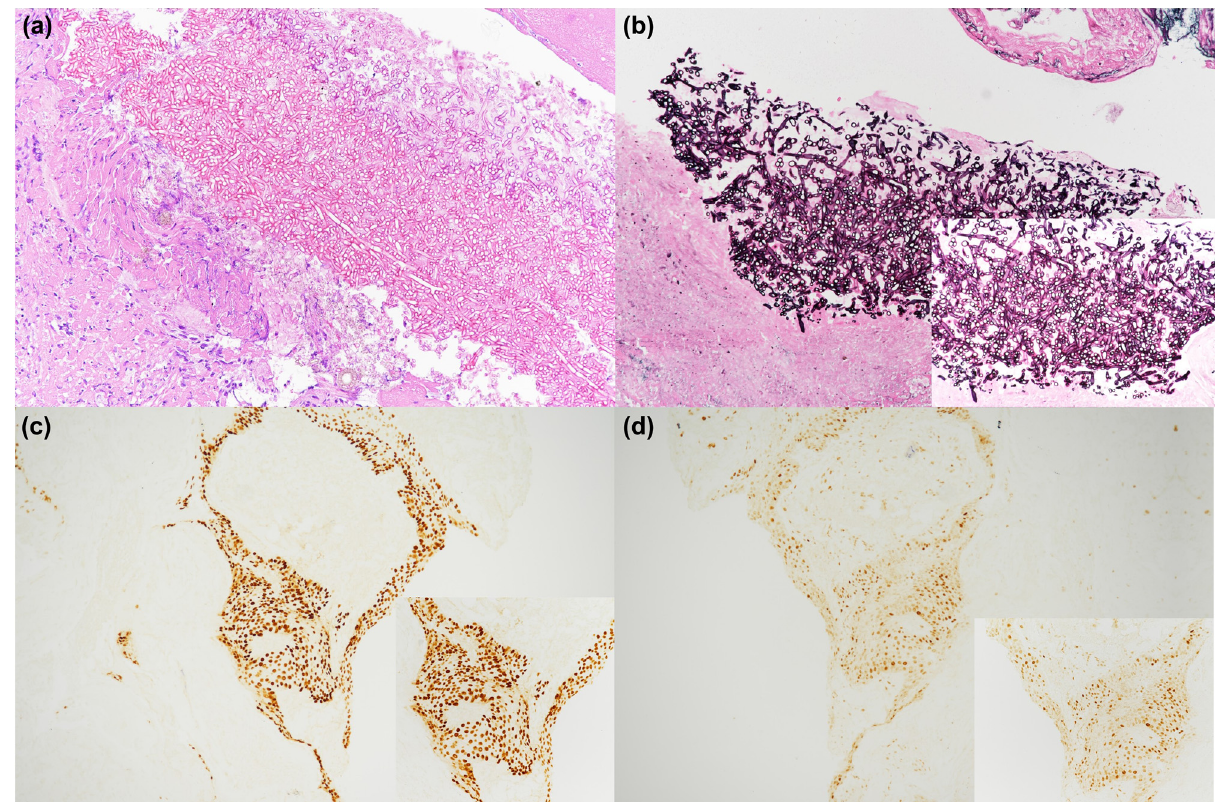
Figure 2: Pathology of metastatic squamous cell carcinoma coexisting with Aspergillus fumigatus : ( a ) clumps of septated fungal hyphae in hematoxylin and eosin stain. ( H&E, 200 ×) , ( b ) Aspergillus fumigatus in Grocott ’ s methenamine silver stain. ( GMS, 200 ×) ; inset of a high - power microphotograph of GMS staining ( GMS, 400 ×) , ( c ) polygonal tumor cells arranged in solid nests and immunohistochemical study reveals positivity for p40 ( IHC, p40, 100 ×) ; inset of a 200 × microphotograph of p40 immunostaining ( IHC, p40, 200 ×) , and ( d ) polygonal tumor cells arranged in solid nests and immunohistochemical positivity for p53 ( IHC, p53, 100 ×) ; inset of a 200 × microphotograph of the p53 staining ( IHC, p53, 200 ×) .